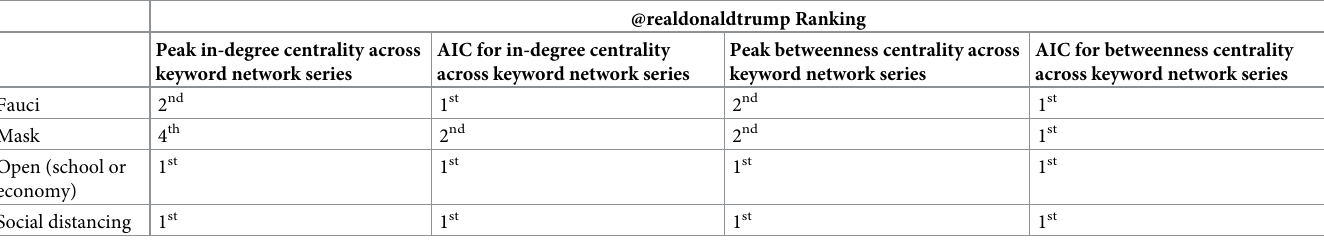
Table 1. Ranking for @realdonaldtrump in select keyword